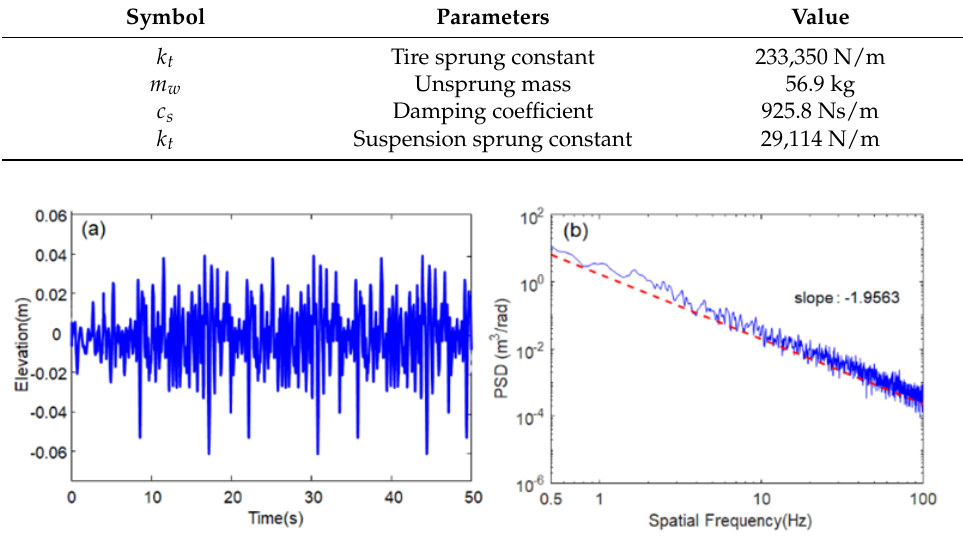
Table 1. Parameters for the simulation of the quarter-car suspension model and AEKF-UI.